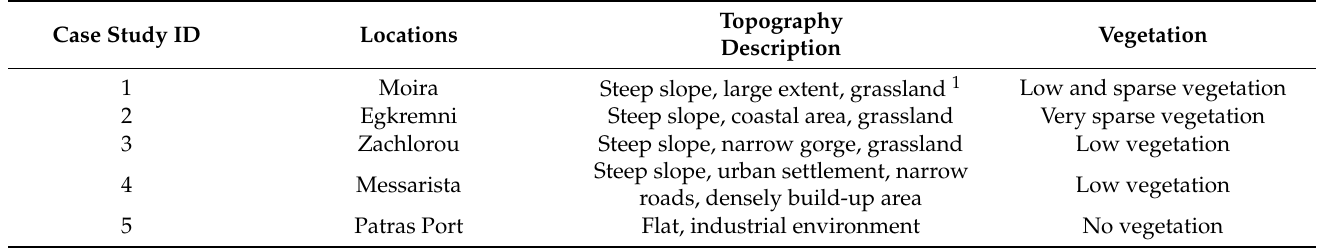
Figure 1. Location of the five case studies within Greece and UAV orthophotos of each area of interest. Table 1. Selected case studies and characteristics (topography, vegetation).